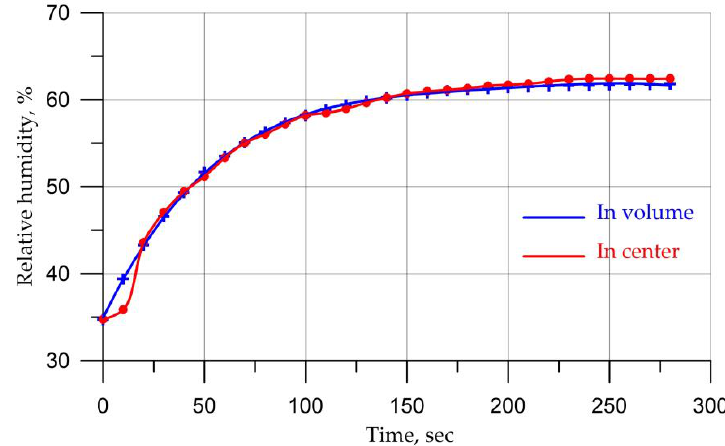
Figure 7. Average relative